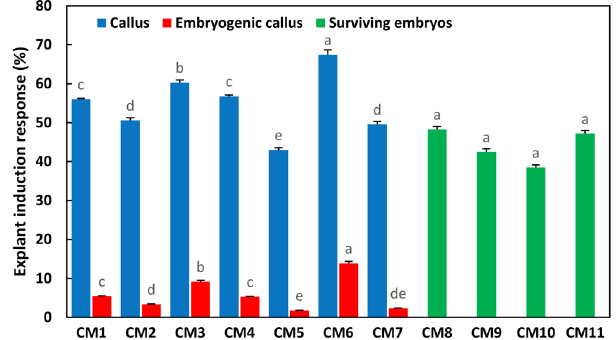
Figure 4. Effects of induction media CM1–CM11 on embryogenic tissue induction. Immature embryos from 25 OP trees in three developmental stages were cultured for 6 weeks in embryogenic tissue induction media CM1–CM11, and the average frequency of callus (represented by blue columns) and embryogenic callus (represented by red columns) induction from CM1–CM7 and the survival rates of embryos (represented by green columns) from CM8–CM11 were determined. Duncan's new multiple range test was used to detect difference at P < 0.05.